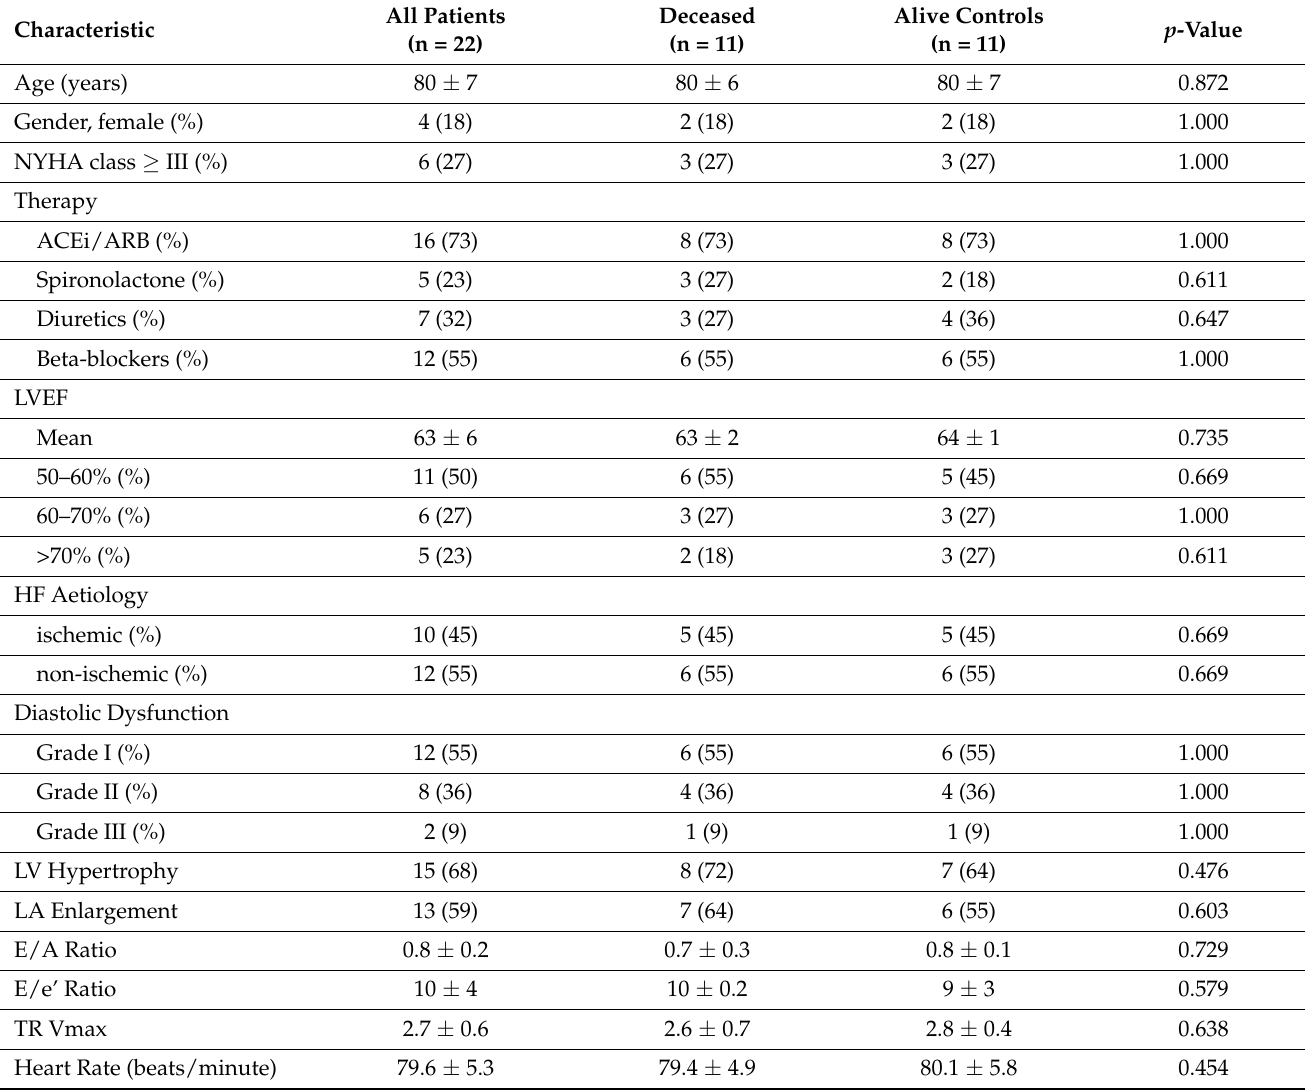
Table 1. Baseline characteristics of the study population between deceased group of patients and alive control group